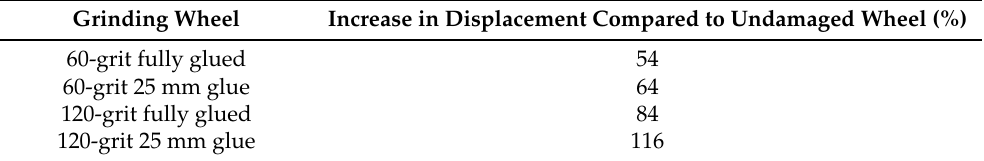
Table 4. Grinding wheel average increase in displacement compared to the undamaged wheel